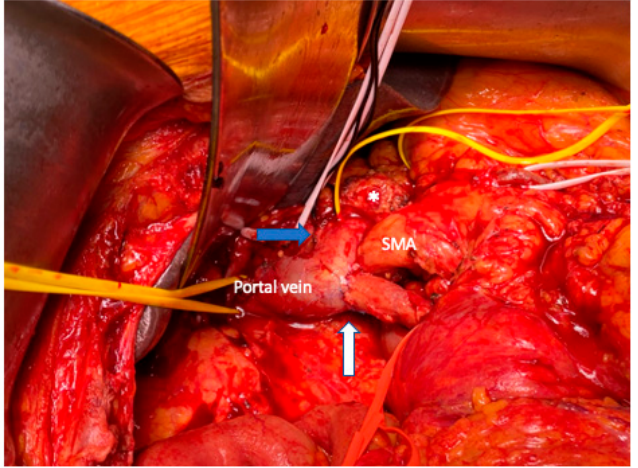
Figure 7. Type 3: segmental superior mesenteric vein resection (white arrow) with primary veno- venous anastomosis. The blue arrow shows the splenic vein. The asterisk, the distal pancreatic stump. SMA, superior mesenteric artery.